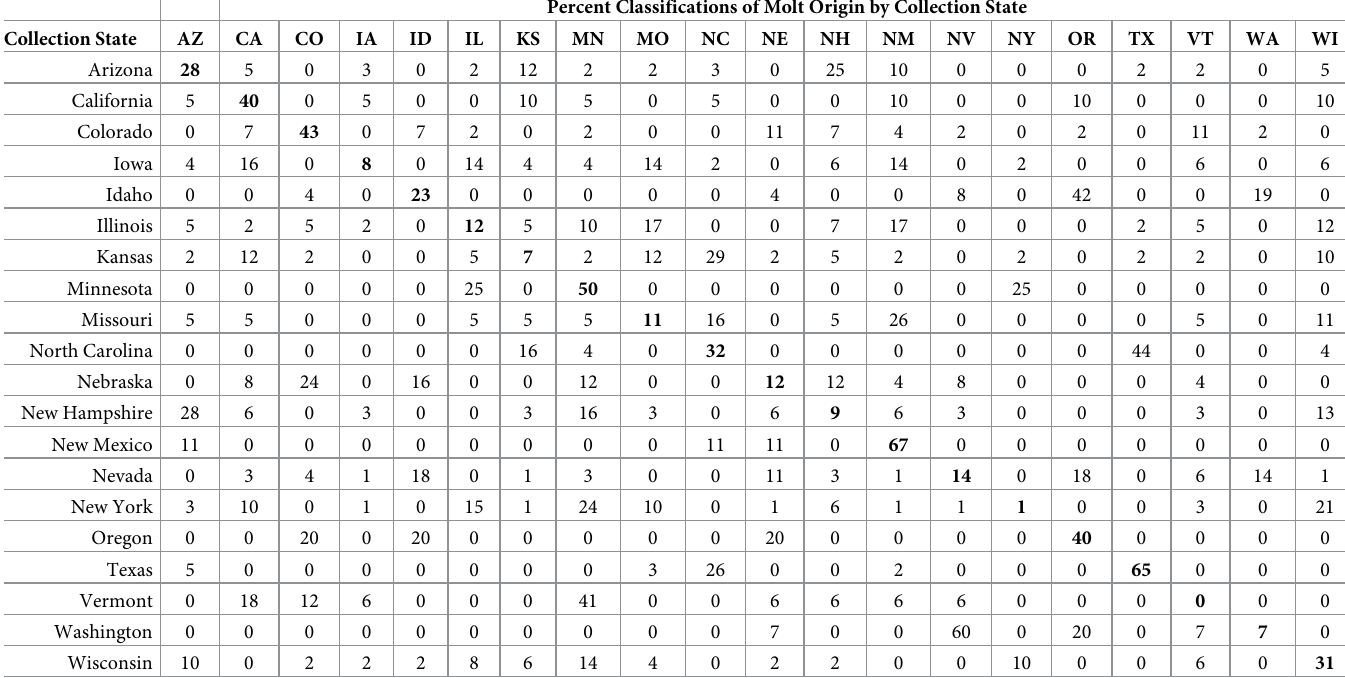
Table 2. Percent of all European starlings ( N = 686) collected at dairies and feedlots throughout the U.S. and assigned to a molt-origin state using a cross-validation summary of the discriminant function analysis of feather isotopes (by collection state, left column). Percent Classifications of Molt Origin by Collection